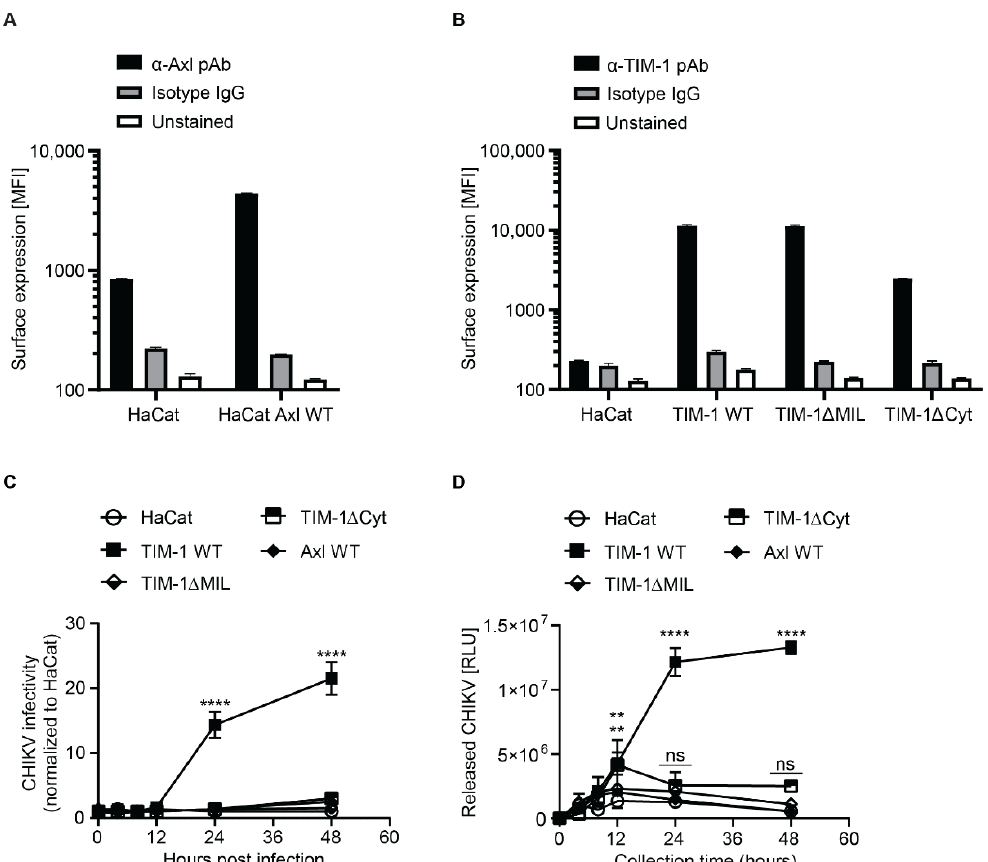
Figure 5. TIM-1 renders HaCat cells permissive to CHIKV. ( A ) Cell surface expression of Axl in HaCat cells with and without ectopic Axl expression (Axl WT) analyzed by antibody staining and flow cytometry. ( B ) Cell surface expression of ectopic TIM-1 WT and TIM-1 mutants in HaCat cells analyzed by antibody staining and flow cytometry. ( C ) Parental HaCat immortalized keratinocytes and HaCat cells expressing either TIM-1 WT, TIM-1 ∆ MIL, TIM-1 ∆ Cyt or Axl WT were inoculated with Asian genotype nano-luciferase CHIKV reporter virus. After four hours, the cells were washed extensively to remove unbound virus. Expression of nano-luciferase attesting for viral replication was monitored over time using luciferase assay. Permissive fold change relative to parental HaCat cells at the indicated time points post infection is shown. ( D ) Released progeny virions in culture supernatants from ( C ) were used to inoculate human dermal fibroblasts and infection levels determined at 24 h post infection. The error bars represent mean ± SEM of three independent experiments. Statistical significance was calculated using a Dunnet’s multiple comparisons test (2way ANOVA) ns > 0.05, ** p < 0.01 and **** p < 0.0001.